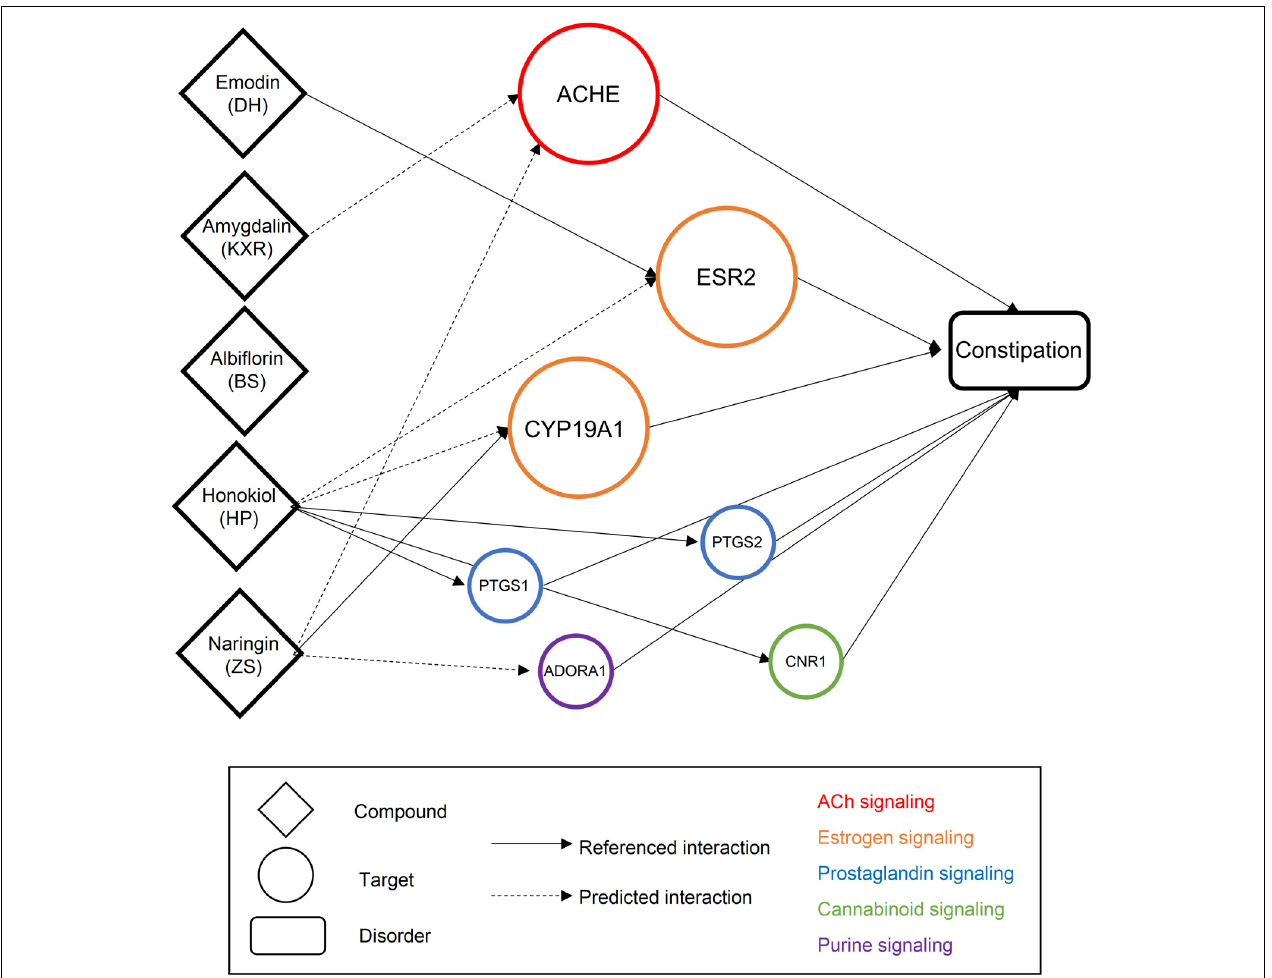
FIGURE 3 | The drug-target-disorder network of MZRW representative compounds for constipation. The prokinetic effects of MZRW representative compounds can be explained by several targets. The compound is linked with biological target if it has reported (solid line) or predicted (dashed line) to be interacted with that target. All the biological targets have been reported to have links with constipation. Overall, these biological targets are belonging to the ACh signaling (red), estrogen signaling (orange), prostaglandin signaling (blue), cannabinoid signaling (green), and purine signaling (purple)